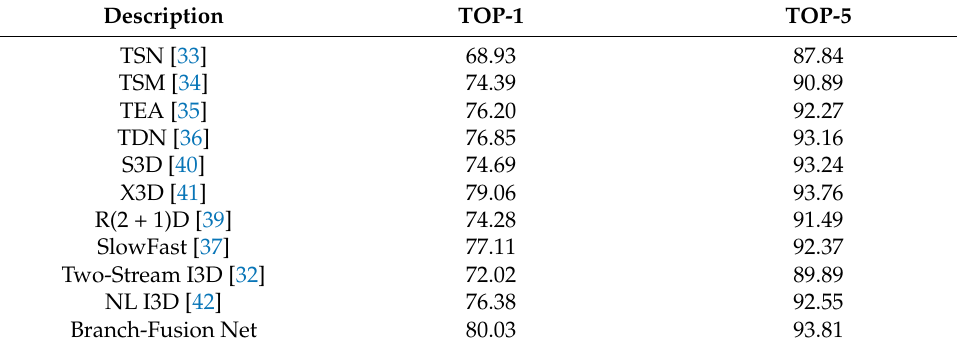
Table 7. Accuracy (%) comparison on Kinetics